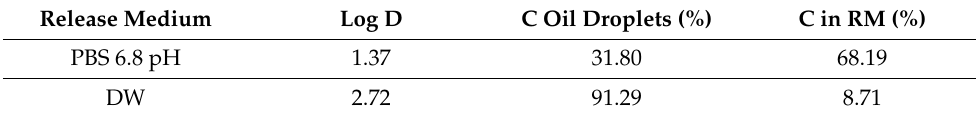
Table 10. log D SEDDS/release medium